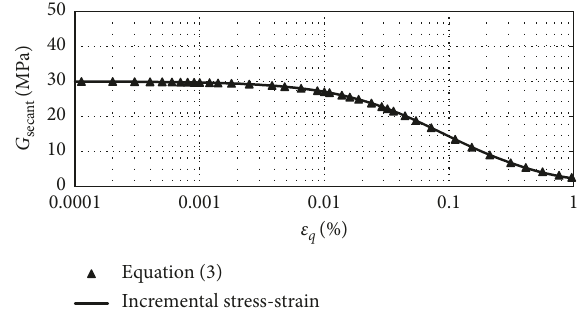
denotes small ss i